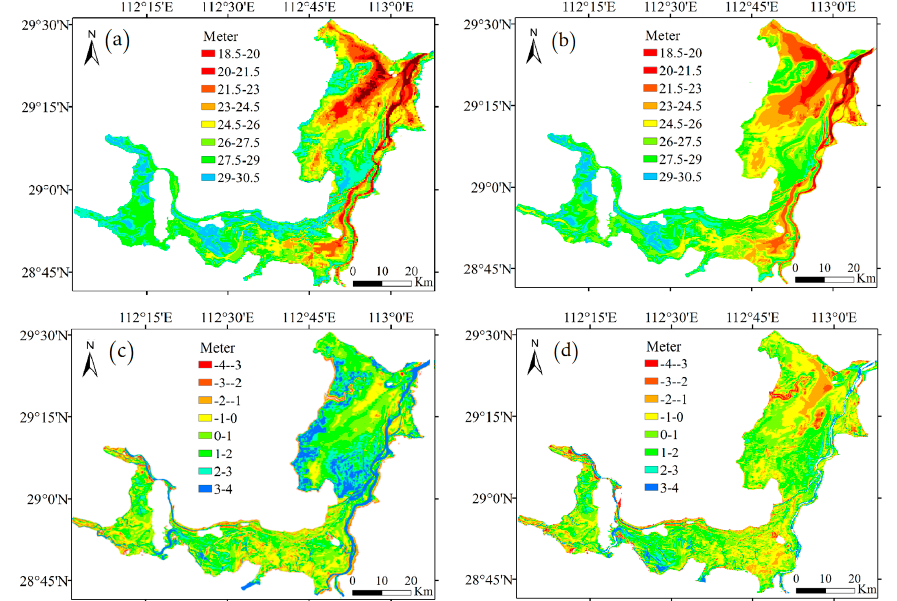
Figure 17. Comparison of the accuracy of topographic inversion before and after adding the ICESat/GLAS data: ( a ) before adding the ICESat/GLAS data; ( b ) after adding the ICESat/GLAS data; ICESat / GLAS data: ( a ) before adding the ICESat / GLAS data; ( b ) after adding the ICESat / GLAS data; ( c ) distribution of the difference between the topographic inversion before adding the ICESat/GLAS ( c ) distribution of the di ff erence between the topographic inversion before adding the ICESat / GLAS data and measured elevation grid models; ( d ) distribution of the difference between the topographic data and measured elevation grid models; ( d ) distribution of the di ff erence between the topographic inversion after adding the ICESat/GLAS data and measured elevation grid models. inversion after adding the ICESat / GLAS data and measured elevation grid